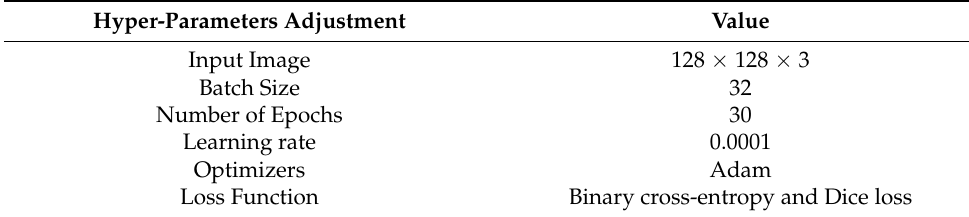
Table 2. The hyper-parameters adjustment and values.